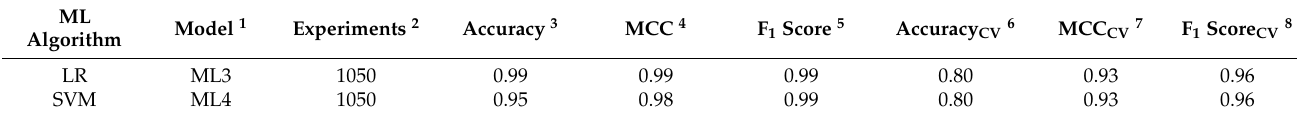
Figure 2. Top 3 levels of the RF second decision tree: most important chemical components from the DA dataset on M. canis bioactivities and EO-virtualized chemical composition. The full tree is reported as Supplementary Figure S2. Green path indicates positive impact on M. canis inhibition, while red path negative influence. The blue box indicates the starting DA dataset composition. In this tree, α -muurolene is indicated necessary for the inhibitory activity, thymol and limonene are important if at low concentrations (lower than 2.5% and 0.2%, respectively) and α -citral at high percentages (more than 28.5%). Table 3. Classification model results for M. canis with data